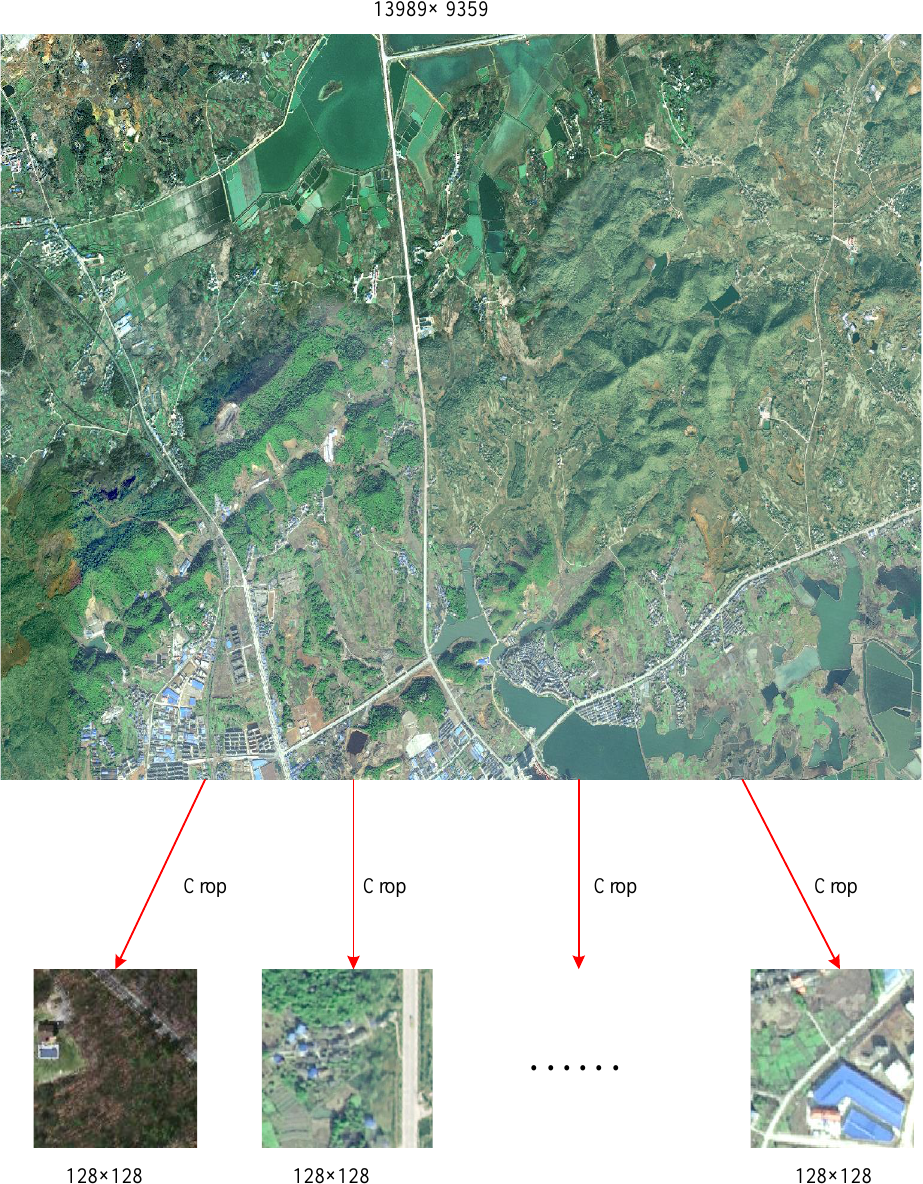
Figure 8. Remote sensing datasets of the Jiangxi and Anhui provinces in